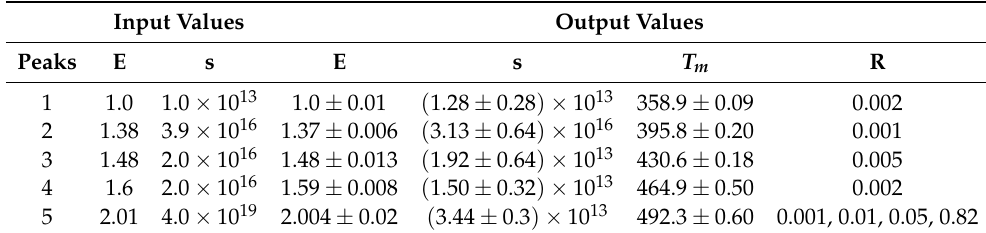
Table 2. Comparison of the kinetic parameters for each energy level in the model, as obtained using CGCD analysis. The input values of the model are compared with the output values from CGCD. The input values for E , s for each peak are common to all reference cases. The units of E are eV, and the units of s are s − 1